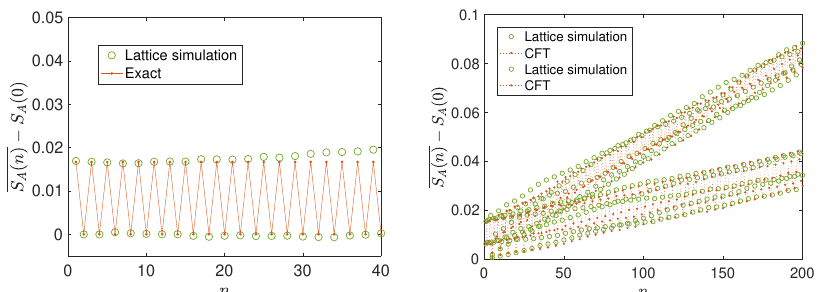
Figure 19: Comparison of lattice simulations and the analytical results / CFT results for the ensemble-averaged entanglement entropy evolution at the type I exceptional point (left) and in the heating phase (right). Left: / L − 1 / 2 = T ( θ ) / L ( θ ) − 1 / 2 = 0, N = 10 4 , and L = 400. The red solid line T 0 eff sample / L − 1 / 2 = T ( θ ) / L ( θ ) − 1 / 2 = 0.1 is the analytical CFT result in (72). Right: T 0 eff = 5000, and L = 200. (top) and 0.3 (bottom), N sample